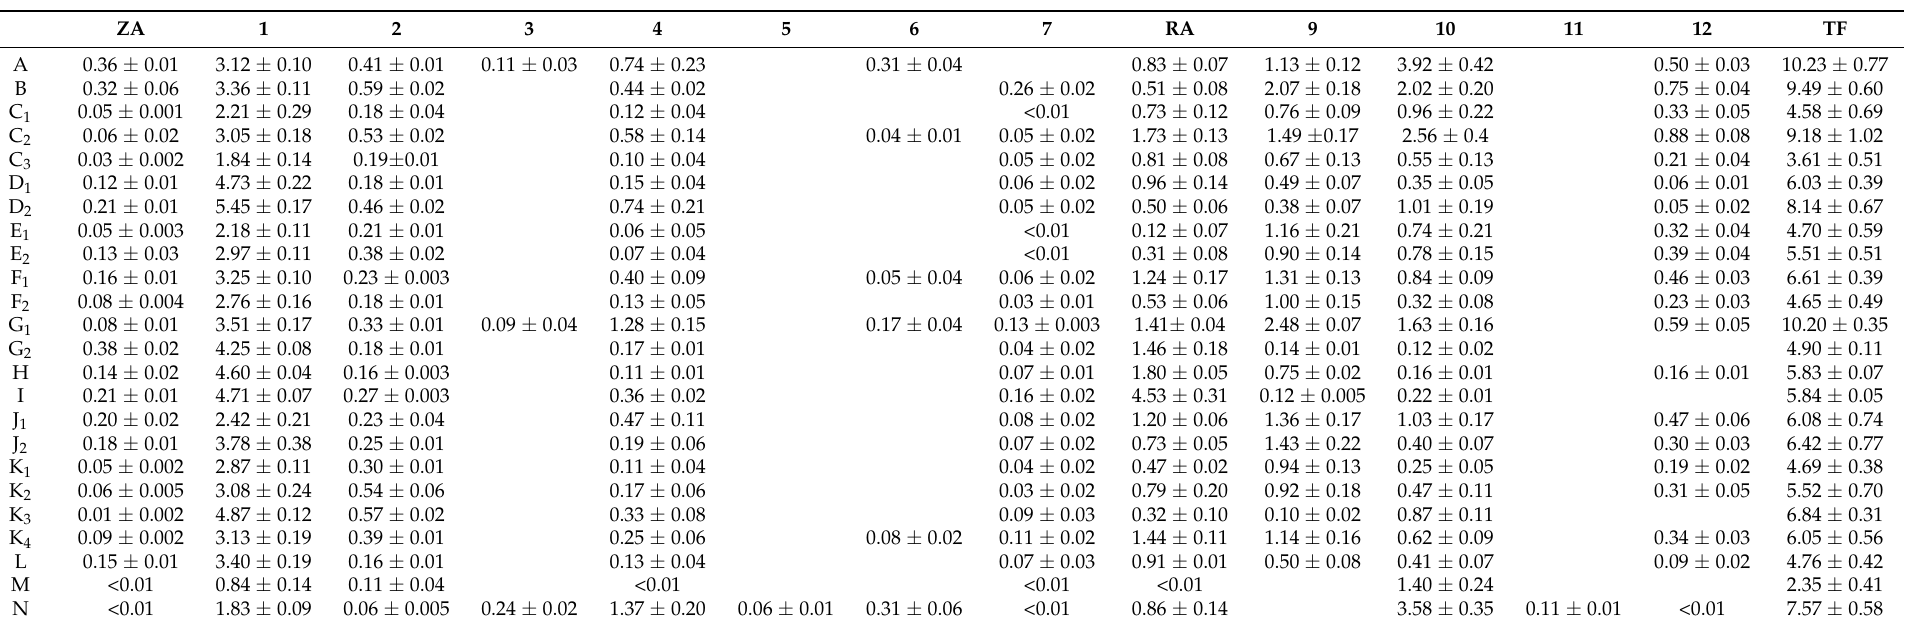
Table 2. Quantitative amounts (mg/g Lut. Eq.) of phenolics found in Zostera marina leaves sampled from different parts of Norway (see Section